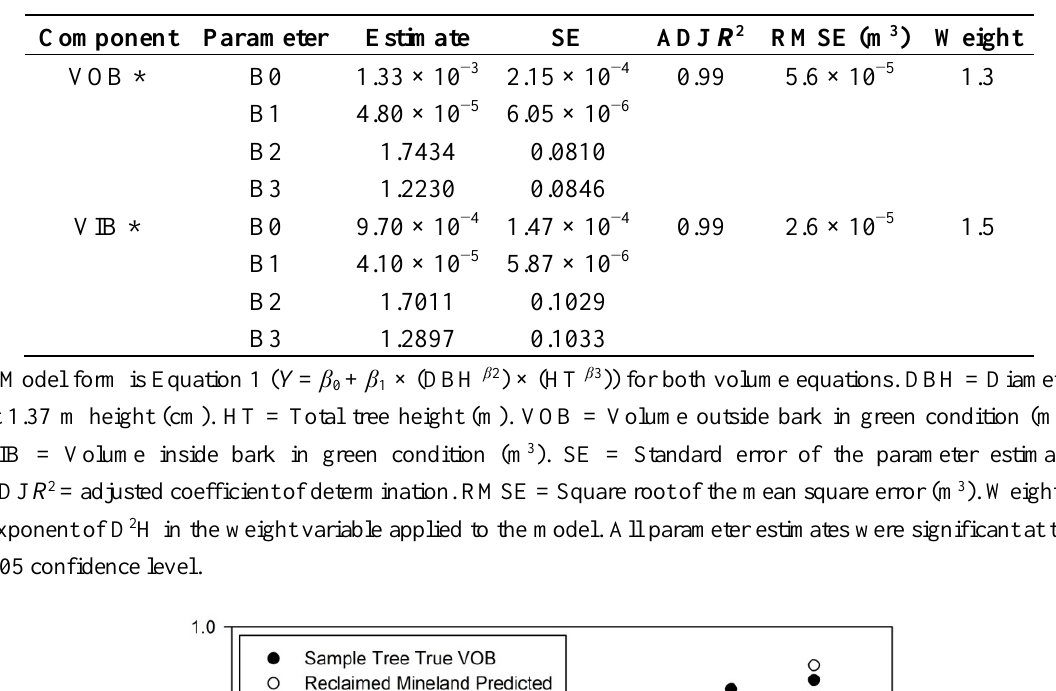
Table 4. Stem volume prediction equations inside and outside bark for loblolly pine on reclaimed mineland in east Texas.